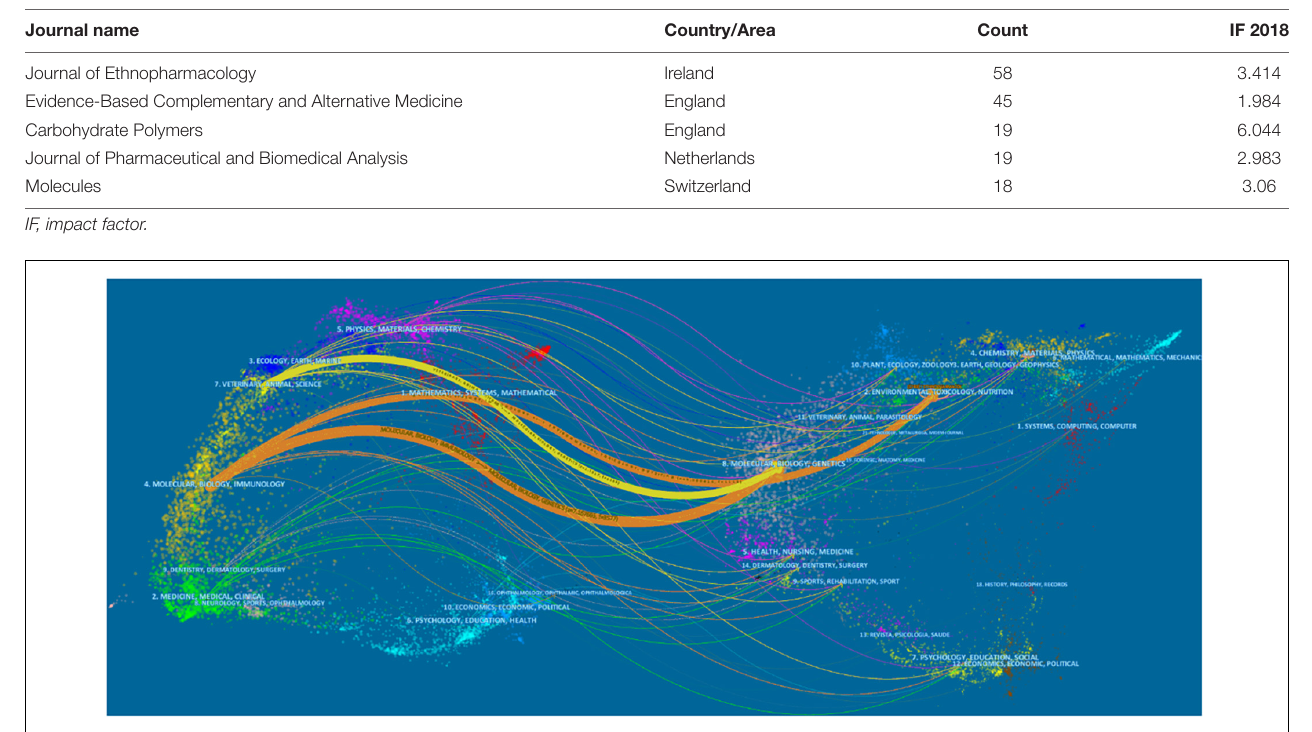
TABLE 2 | The top five journals in Angelica sinensis research.